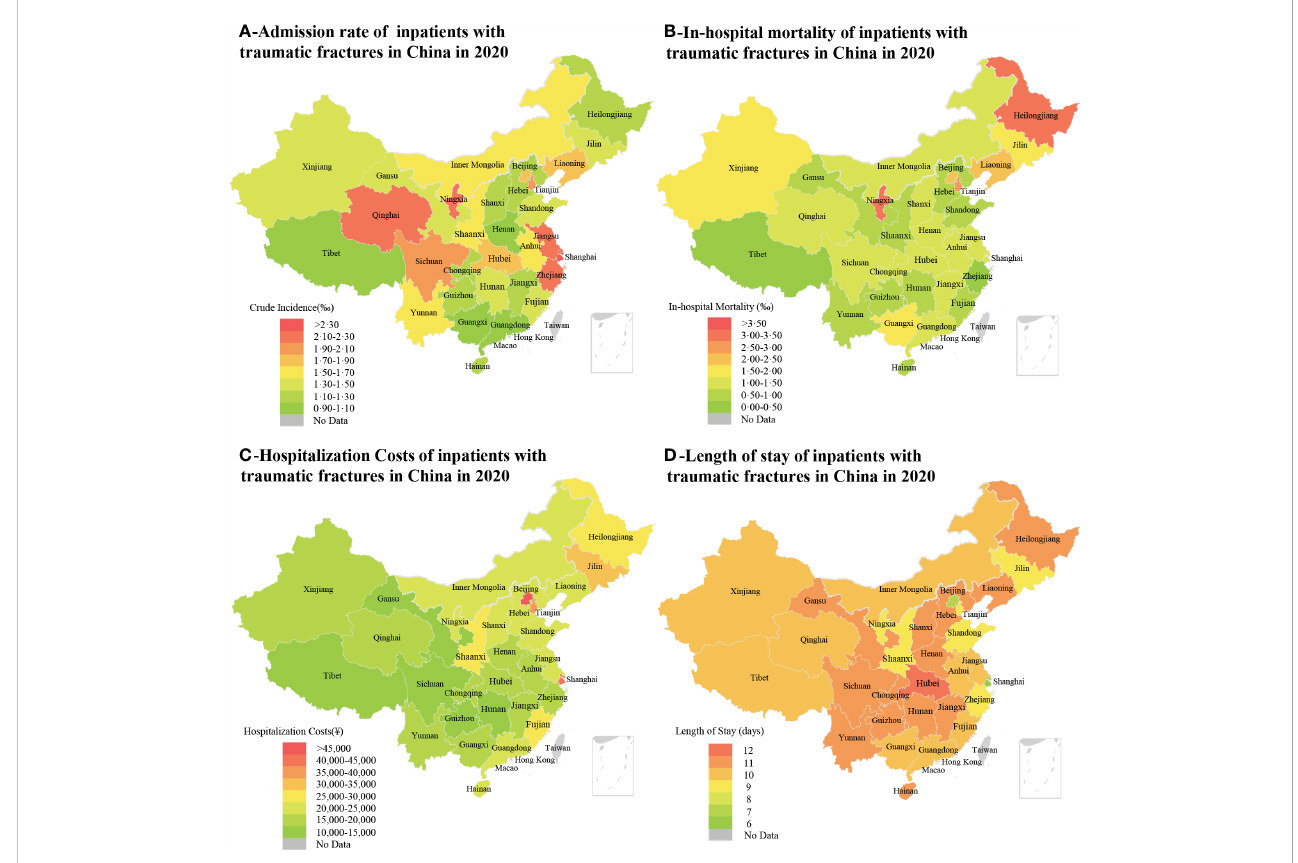
FIGURE 2 The choropleth maps of admission rate (A) , in-hospital mortality (B) , hospitalization cost (C) , and length of stay (D) of inpatients with traumatic fractures for 31 provinces, municipalities and autonomous regions in China in 2020. The study was conducted in mainland China, and the data of Hong Kong, Macao and Taiwan were not displayed (grey color).